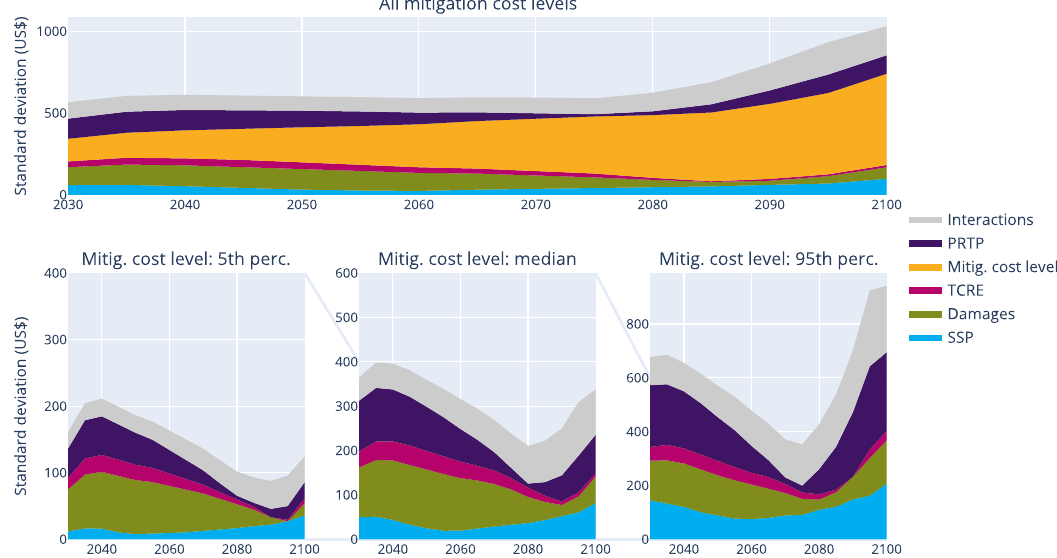
Fig. 3 Contribution to the variance of each parameter as a function of time using Sobol Indices (cost-minimising setting). In the top row, all parameters are considered. In contrast, in the bottom row, the same analysis is performed while fi xing the mitigation costs at three distinct levels: low, medium and high costs. Note that for clarity, the square root of the variance — the standard deviation — has been shown: the unit then becomes US$ instead of the square of it. The decomposition with variances is shown in Supplementary Figure